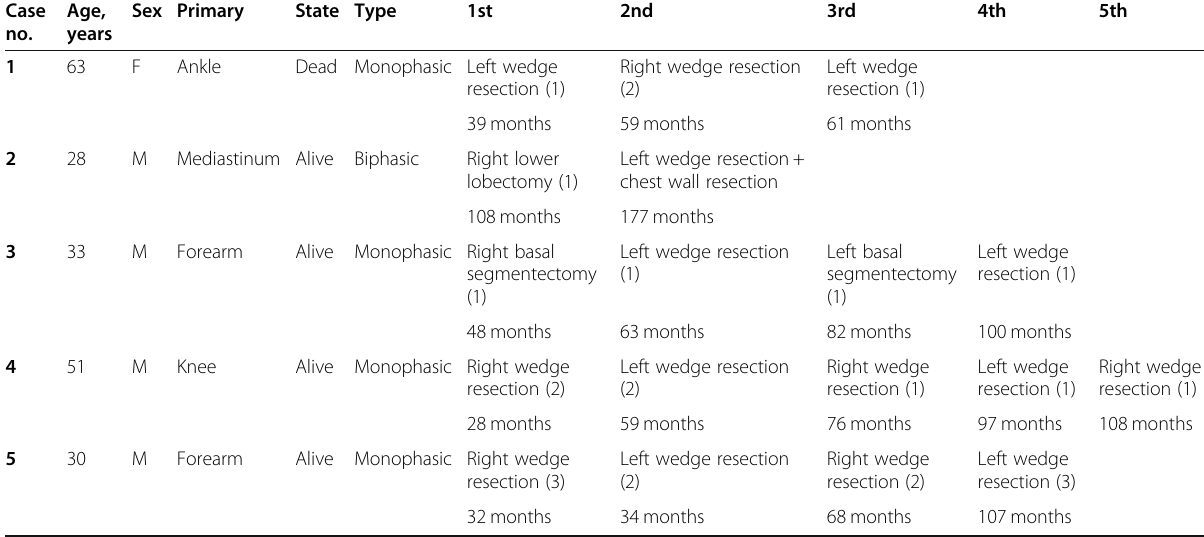
Table 1 Characteristics of the five patients with synovial sarcoma who underwent pulmonary metastasectomy Case